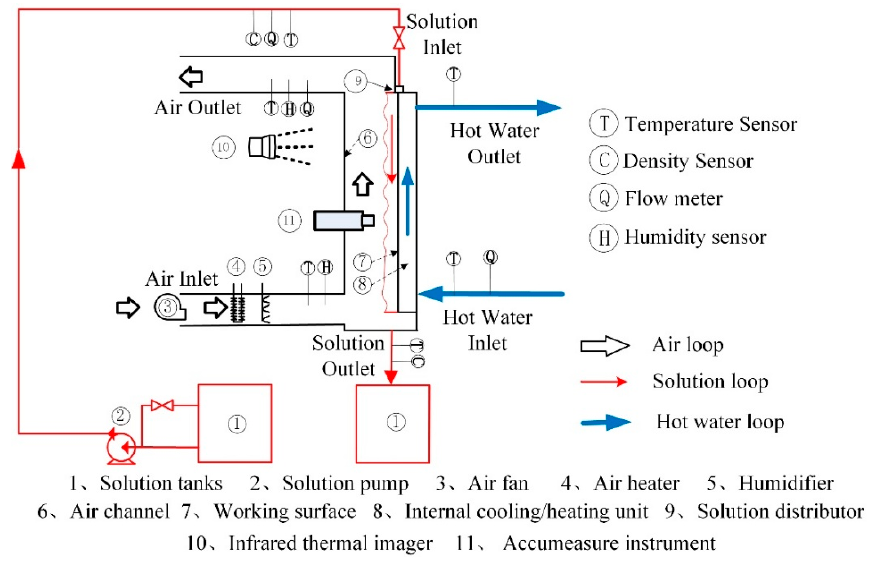
Figure 2. Schematic diagram of the test